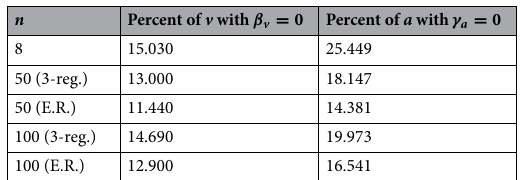
Table 3. The percent of β v and γ a , rounded to three decimal places, that are zero when optimizing ma-QAOA on the family of graphs found in the first column.